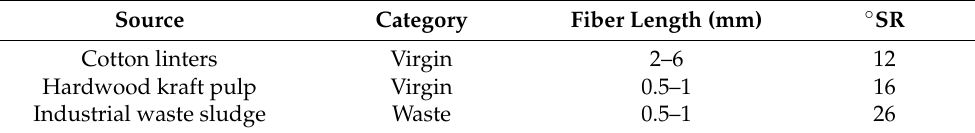
Table 5. Fibre length and ◦ SR of selected cellulose sources for the production of the nanofibers.